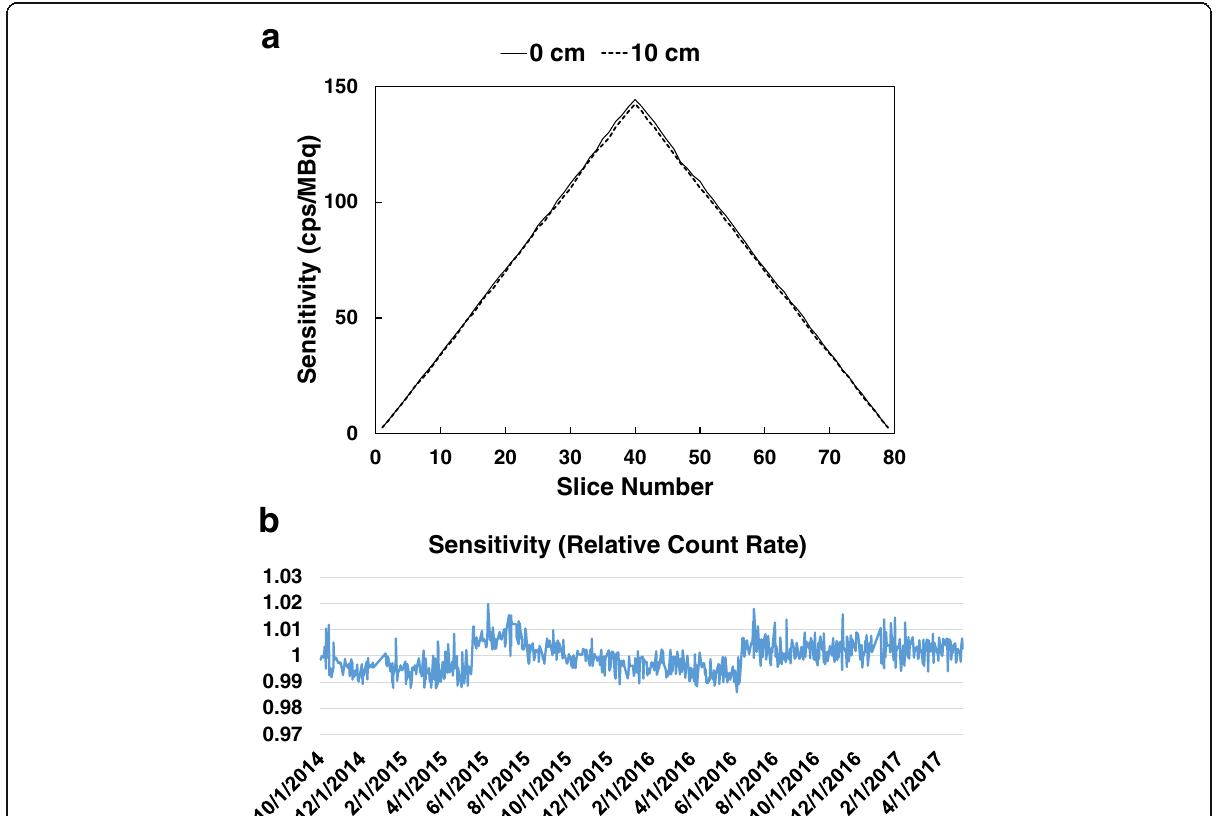
Fig. 4 NEMA sensitivity of the dPET system with ( a ) NEMA sensitivity profile as a function of axial slices and ( b ) sensitivity stability over 31 month (< 1.5% variability) with two jump points in June 2015 and July 2016 after system recalibration